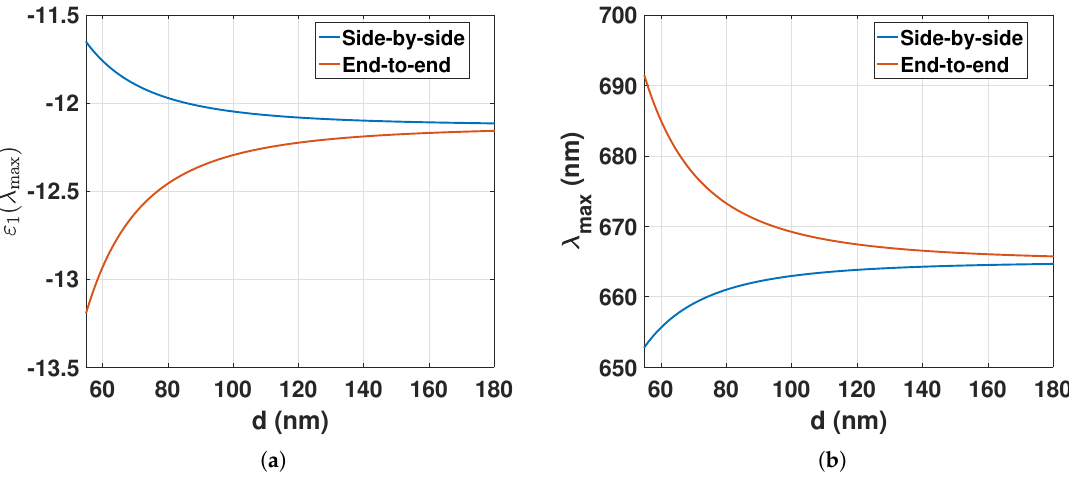
Figure 2. ( a ) Resonance permittivities (Equation (11)) of two identical GNRs in the s-s or e-e configuration for decreasing d ; ( b ) λ max (Equation (14)) of two identical GNRs in the s-s or e-e configuration for decreasing d . ε m = n 2 m = 1.33 2 , λ p = 183 nm, GNR width = 19 nm, GNR length = 50 nm, and AR =